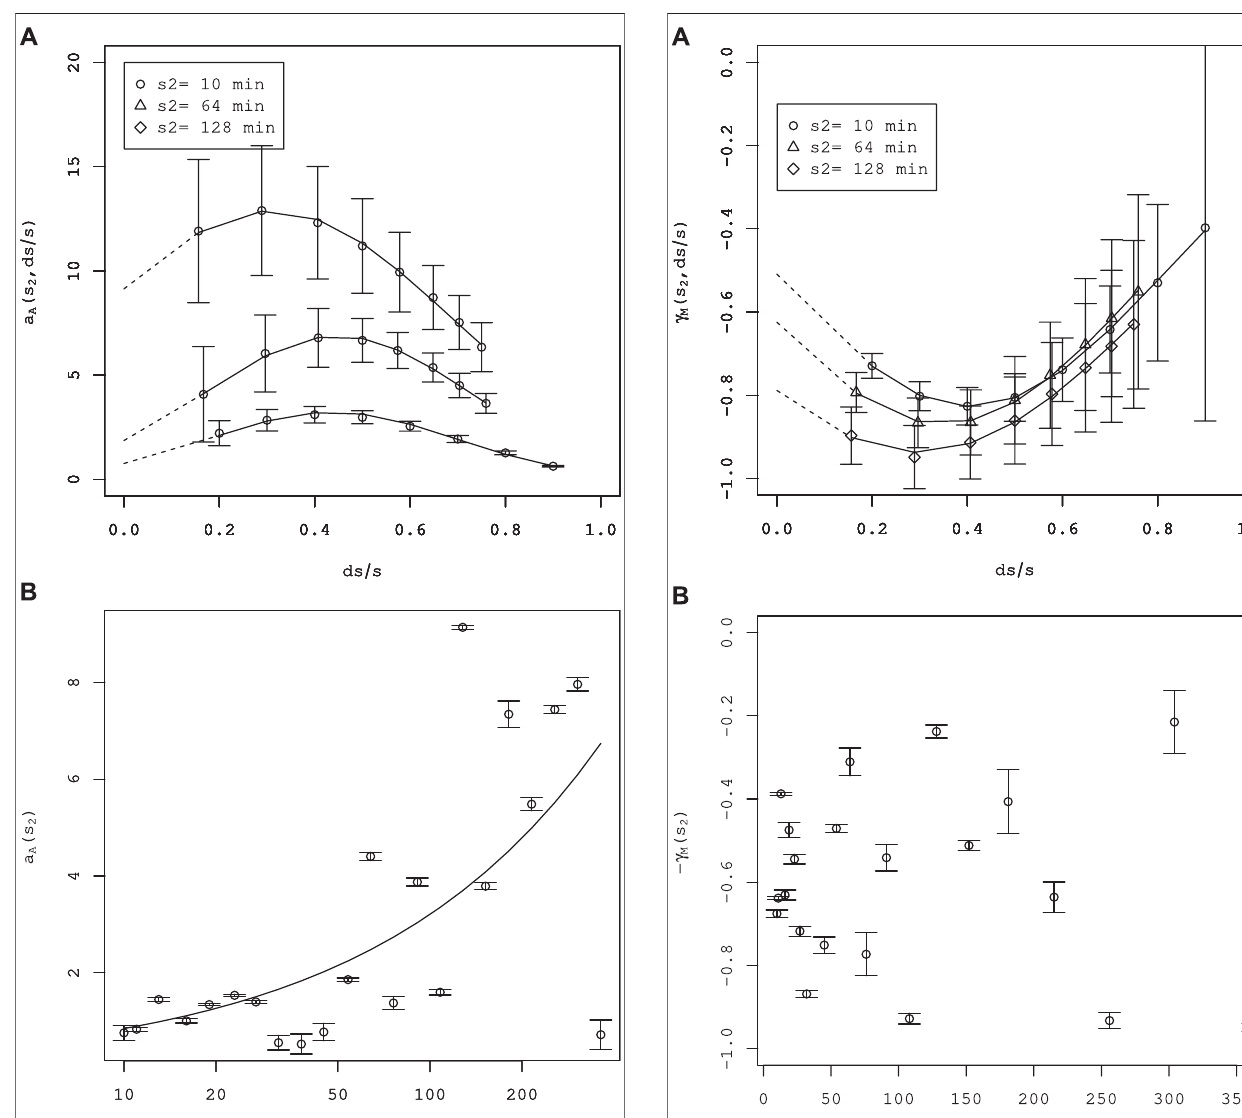
FIGURE 4 | Estimation of the parameter a A ( s ) . (A) The parameter a A ( s 2 , ds / s ) obtained by the regressions shown in Figure 3 and nonlinear fi tting log ( a ( s , ds / s )) (cid:2) a + b ( ds / s ) + c ( ds /s ) 2 . The standard errors of A regression Eq. 28 are denoted by an error bar. (B) a A ( s ) (cid:2) exp ( a ) (see the text). The standard errors of nonlinear fi ttings are denoted by an error bar. The solid line shows the least-squares fi t of a A ( s ) to the power law